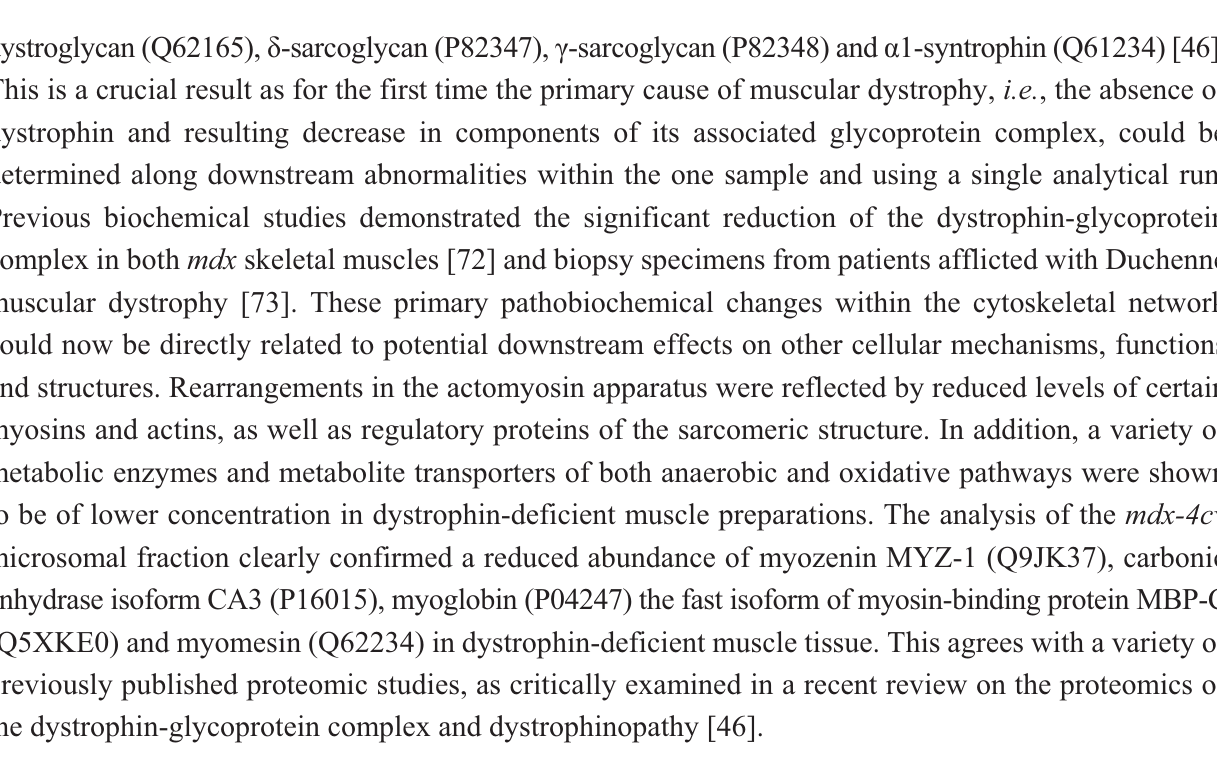
Table 1. List of changed muscle proteins with a reduced concentration of more than 3-fold in the mdx-4cv microsomal fraction (Table S1 in the supplementary materials lists additional proteomic